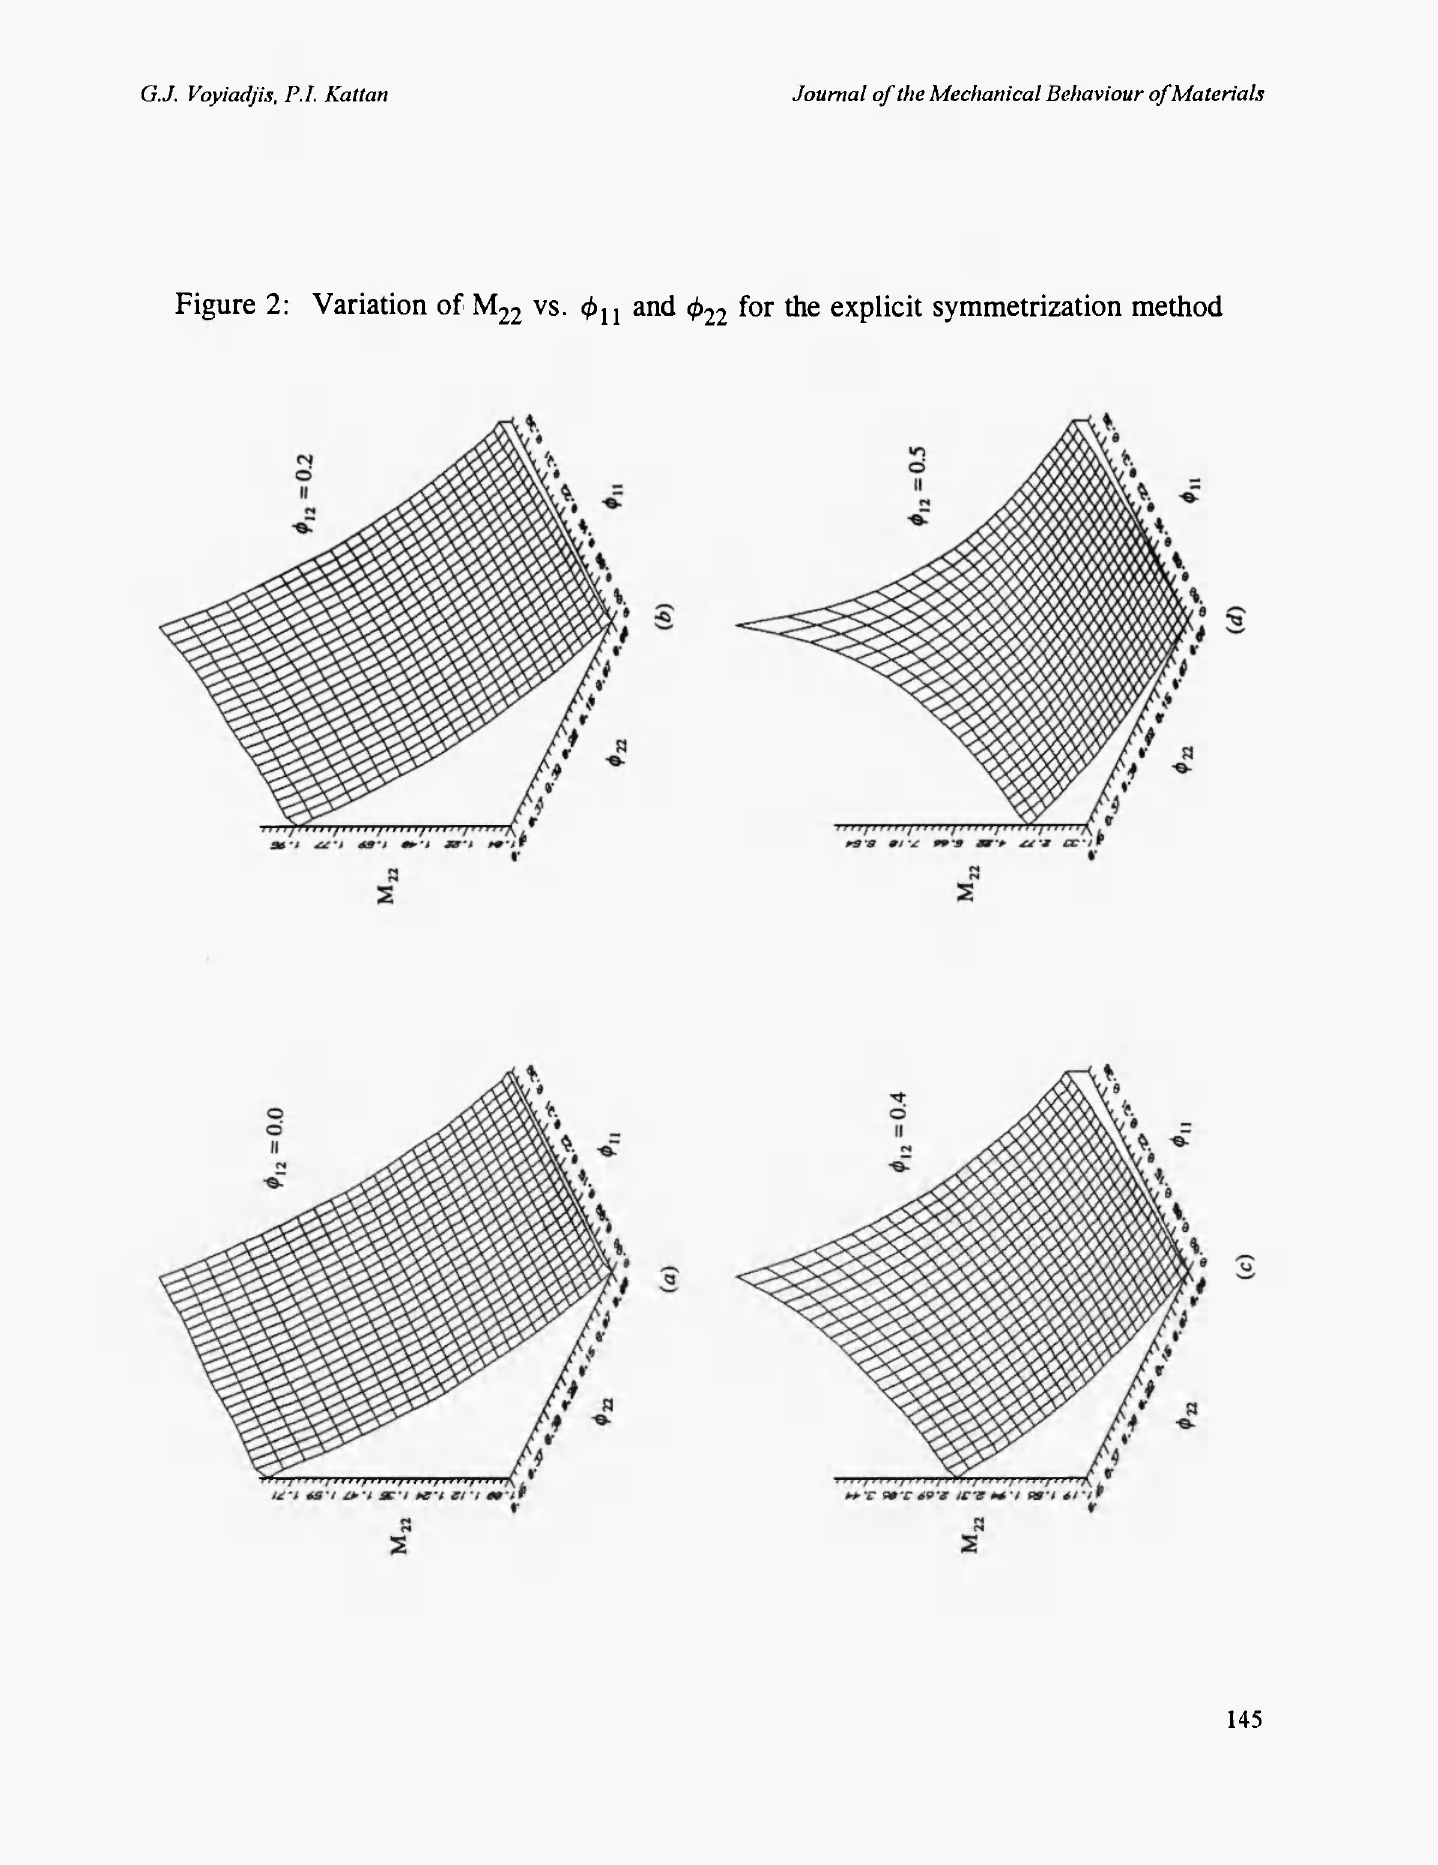
Figure 2: Variation of M